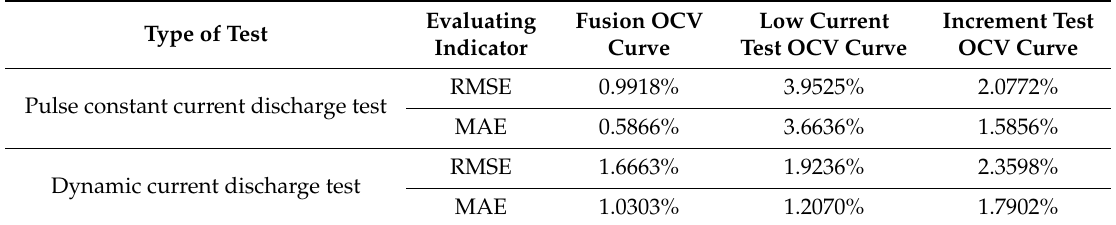
Table 2. Comparison of SOC estimation error for di ff erent OCV